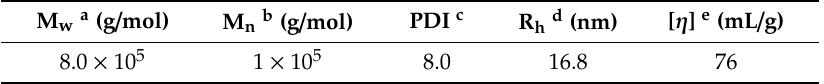
Table 3. Macromolecular characteristics of